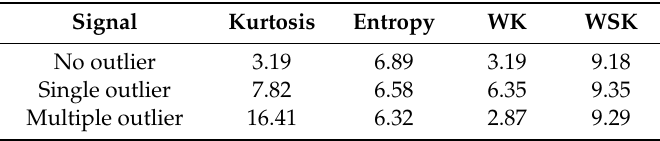
Figure 4. The time domain waveform of the simulation signal: ( a ) No outlier, ( b ) single outlier, and ( c ) multiple outlier. Table 1. The comparisons among different indicators.